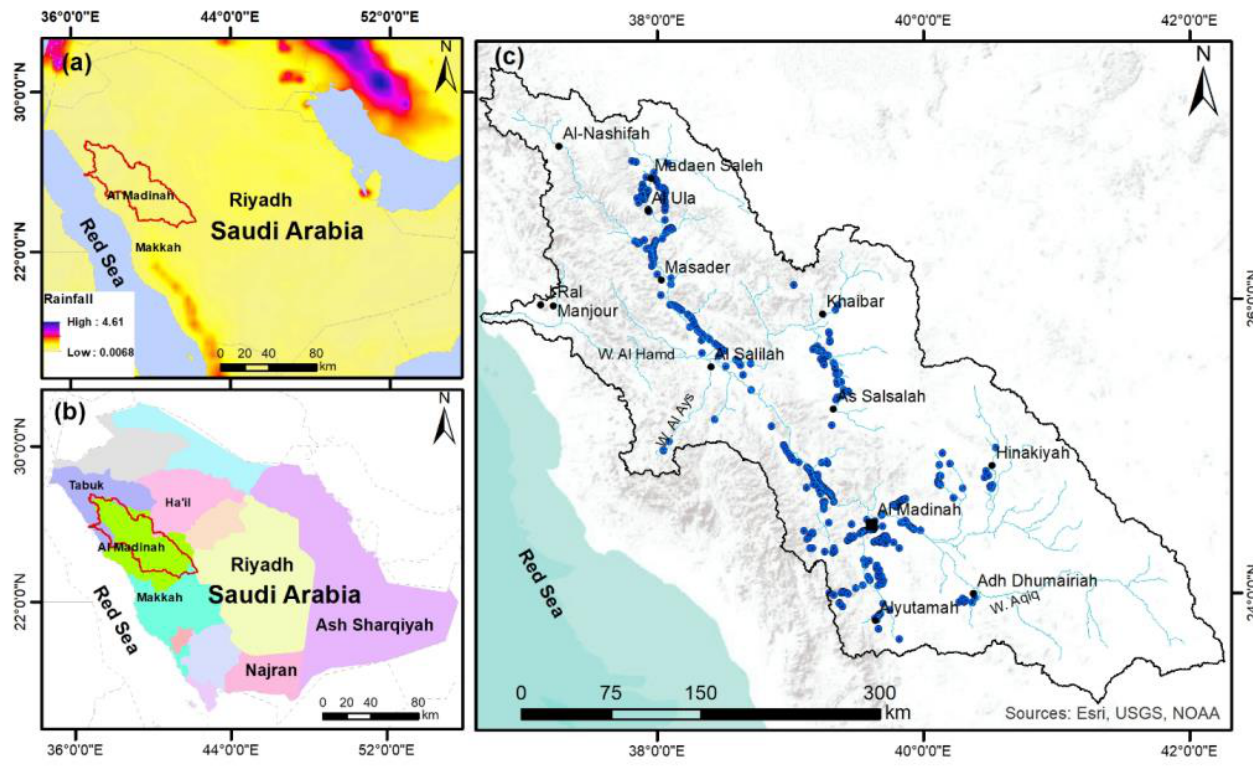
Figure 1. Location map of the Wadi Al Hamdh watershed. ( a ) A watershed of the study area in red overlain the Rainfall map; ( b ) A red polygon of the study area overlain the Saudi Administrative map; ( c ) Points showing farms, and wells.